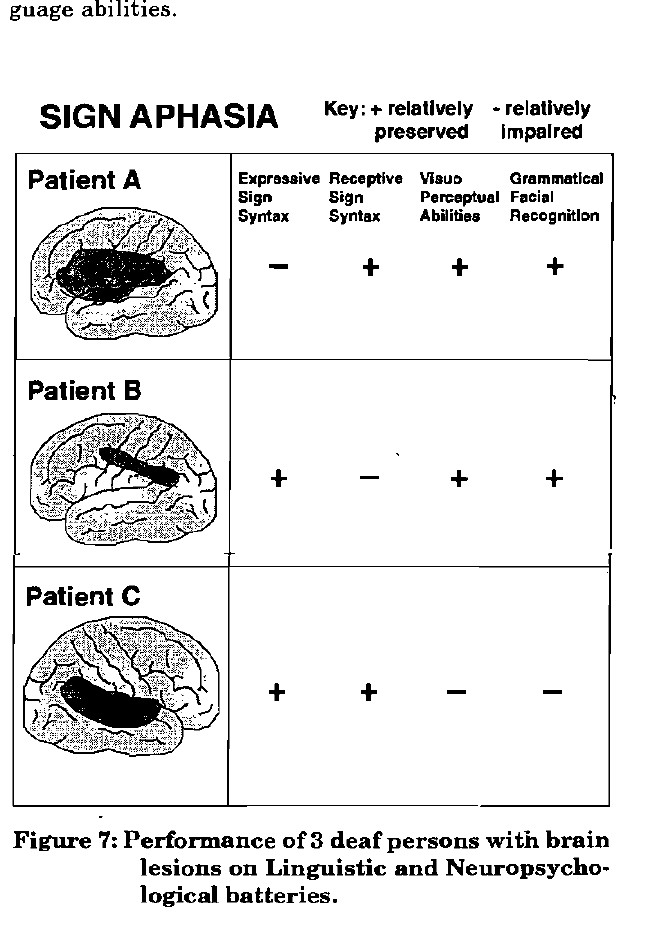
Figure 7: Performance of 3 deaf persons with brain lesions on Linguistic and Neuropsycho- logical